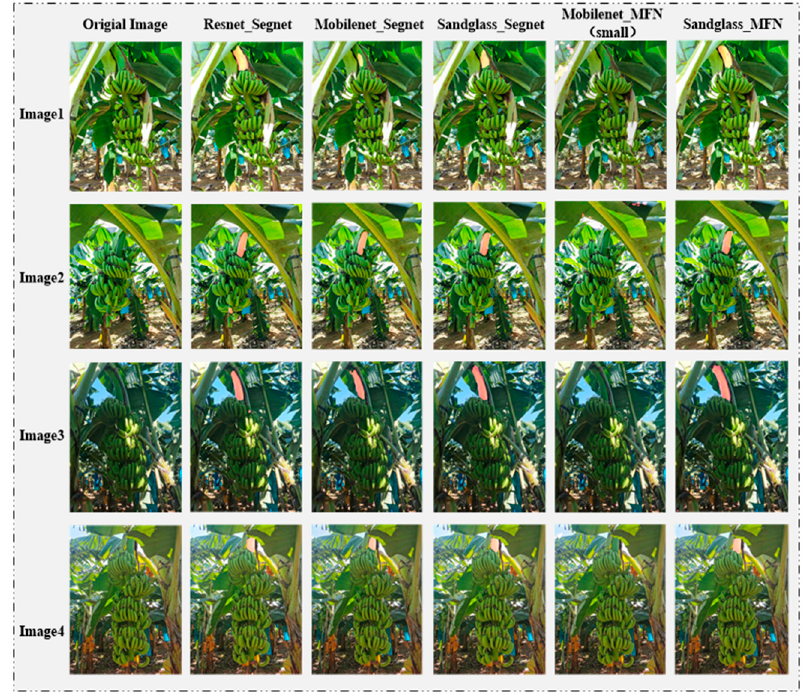
Figure 15. Segmentation effects of all the network models.